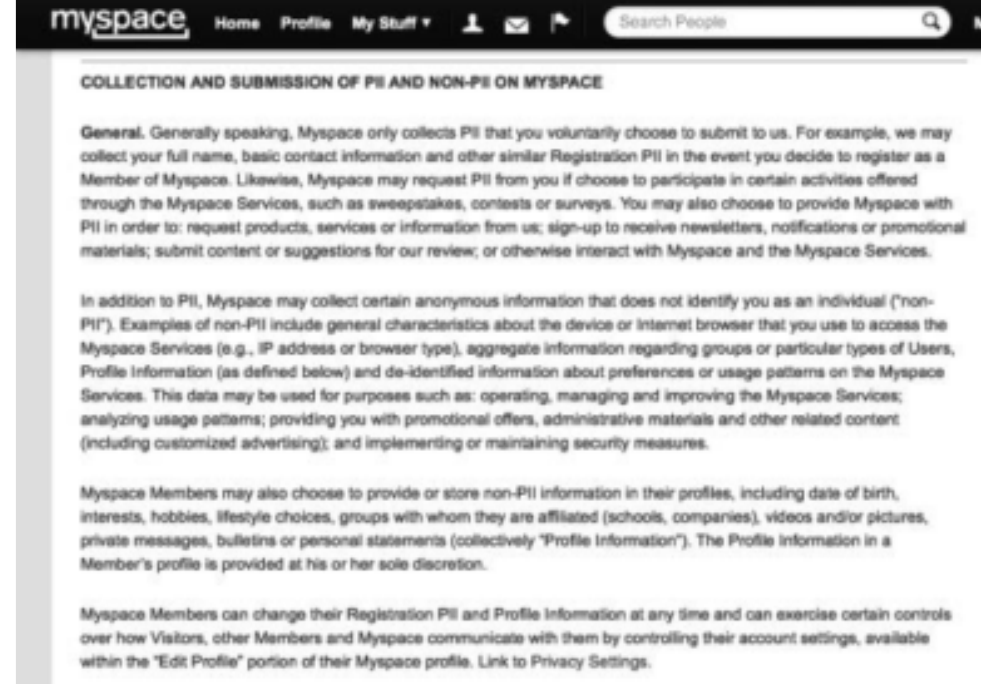
Figure 1. MySpace privacy